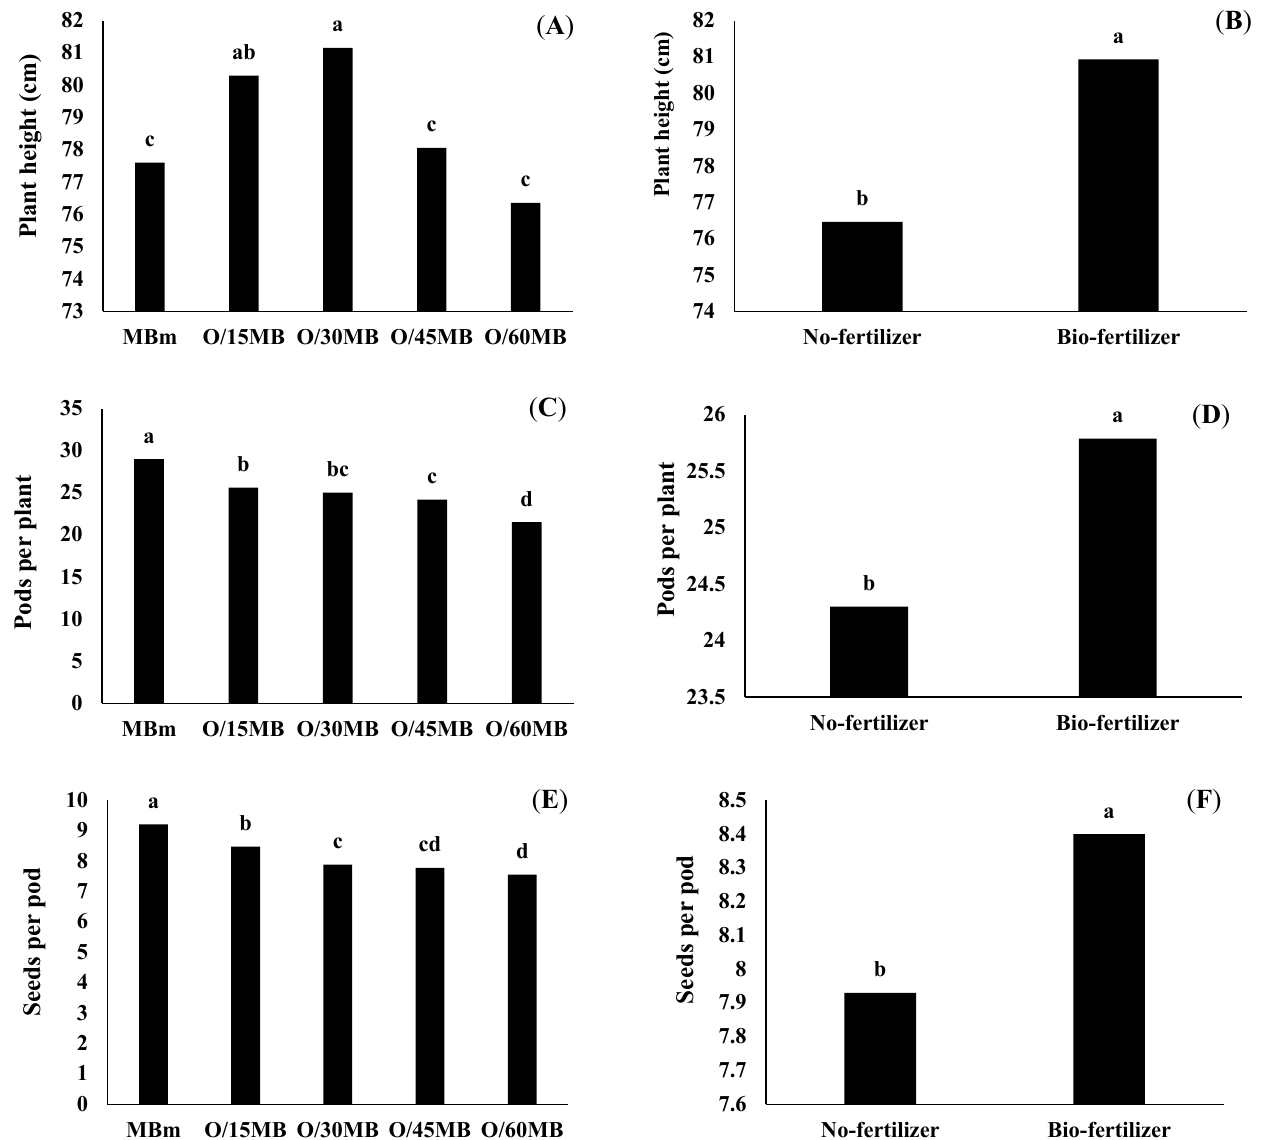
Figure 6. The main effect of cropping patterns ( A , C , E ) and fertilizer application ( B , D , F ) on the plant height, pods per plant − 1, and seeds per pod − 1 of mung bean. MBm: mung bean monocropping; O/15MB: intercropping ratios of 100% marjoram + 15% mung bean; O/30MB: 100% marjoram + 30% mung bean; O/45MB: 100% marjoram + 45% mung bean; O/60MB: 100% marjoram + 60% mung bean. Different lower-case letters above the bars indicate significant ( p ≤ 0.05) differences.